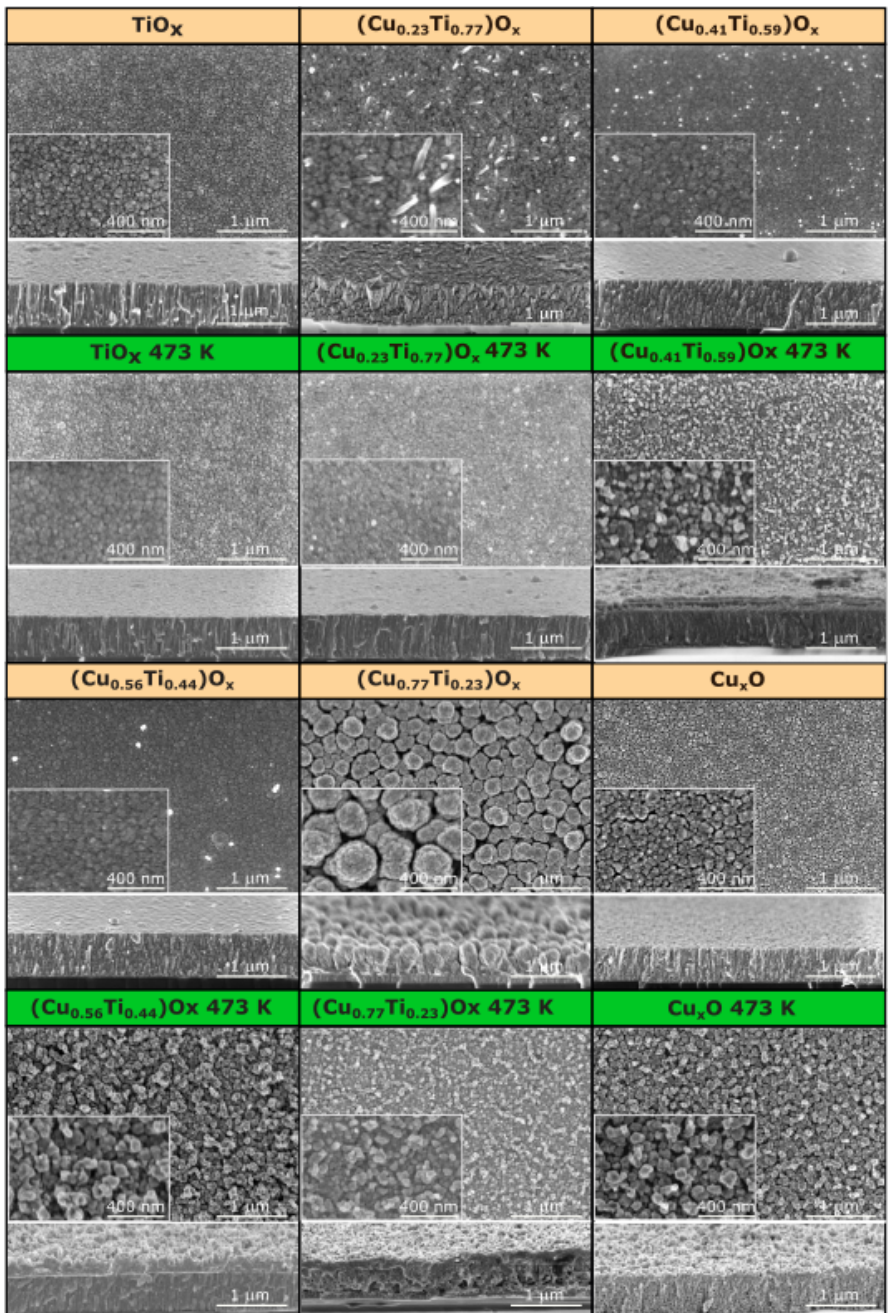
Figure 3. Scanning electron microscopy images of the surface and cross-section of as-deposited and annealed at 473 K TiO x , (CuTi)Ox, and Cu x O thin films. After annealing at 473 K, no significant changes occurred on the surface of the TiO x